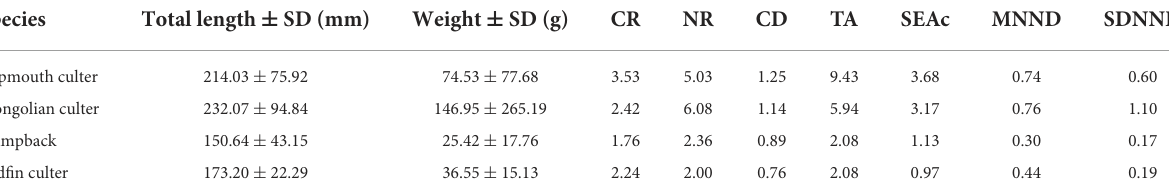
TABLE 2 Layman’s metrics and corrected standard ellipse area of topmouth culter, Mongolian culter, humpback, and redfin culter in Lihu Lake. Species